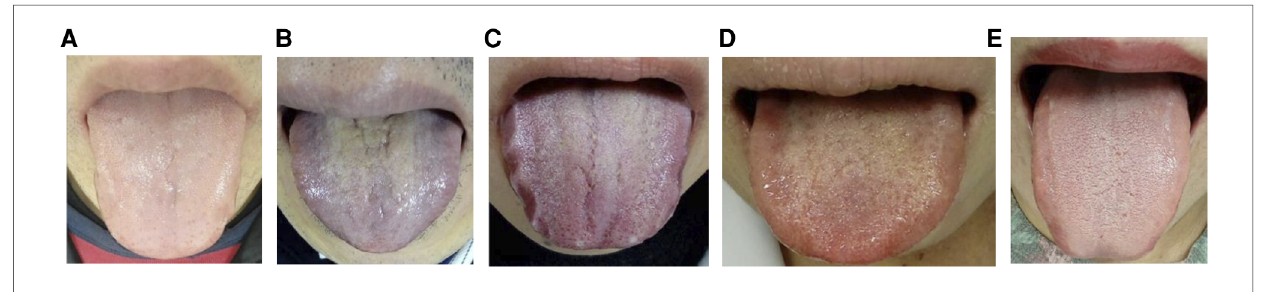
FIGURE 3 Multiple-choice questions to ask for the normal color tongue (Study 2). Q. Which tongue color is often seen in healthy people? Please select one. The correct answer is (e). The answer distribution of medical professionals was ( A ) n =16 (15%); ( B ) n =0; ( C ) n =0; ( D ) n =4 (3.7%); and ( E ) n =87 (81.3%). The answer distribution of the students was ( A ) n =10 (14.8%); ( B ) n =0; ( C ) n = 0; ( D ) n =0; ( E ) n =46